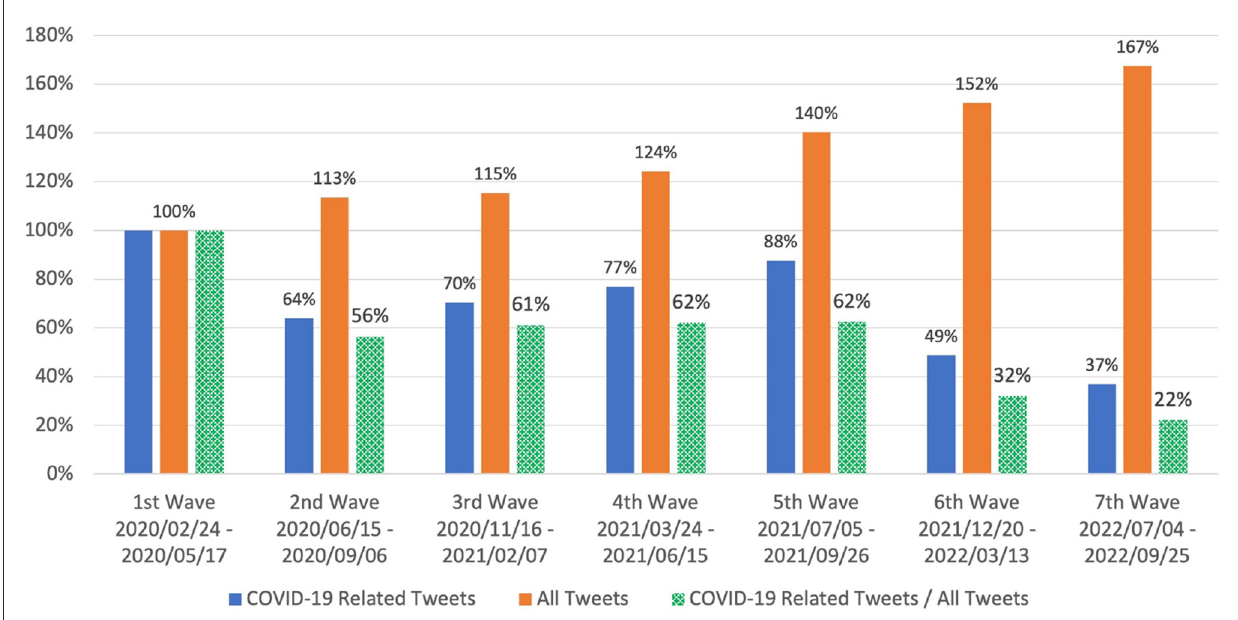
FIGURE4 Social media (Twitter) reaction in Japan measured by total tweet count (Equation 1) for each COVID-19 wave over period of 12 weeks: 7 weeks before, 1 week during, and 4 weeks after peak of corresponding wave. Values shown are relative to those for 1st wave. Social media reaction in 6th and 7th waves was obviously much less than that in previous waves. Additionally, total tweet count ratio (“COVID-19 related tweets” vs. “all tweets”) dropped to 32% in 6th wave and 22% in 7th wave compared with 56-62% in 2nd - 5th